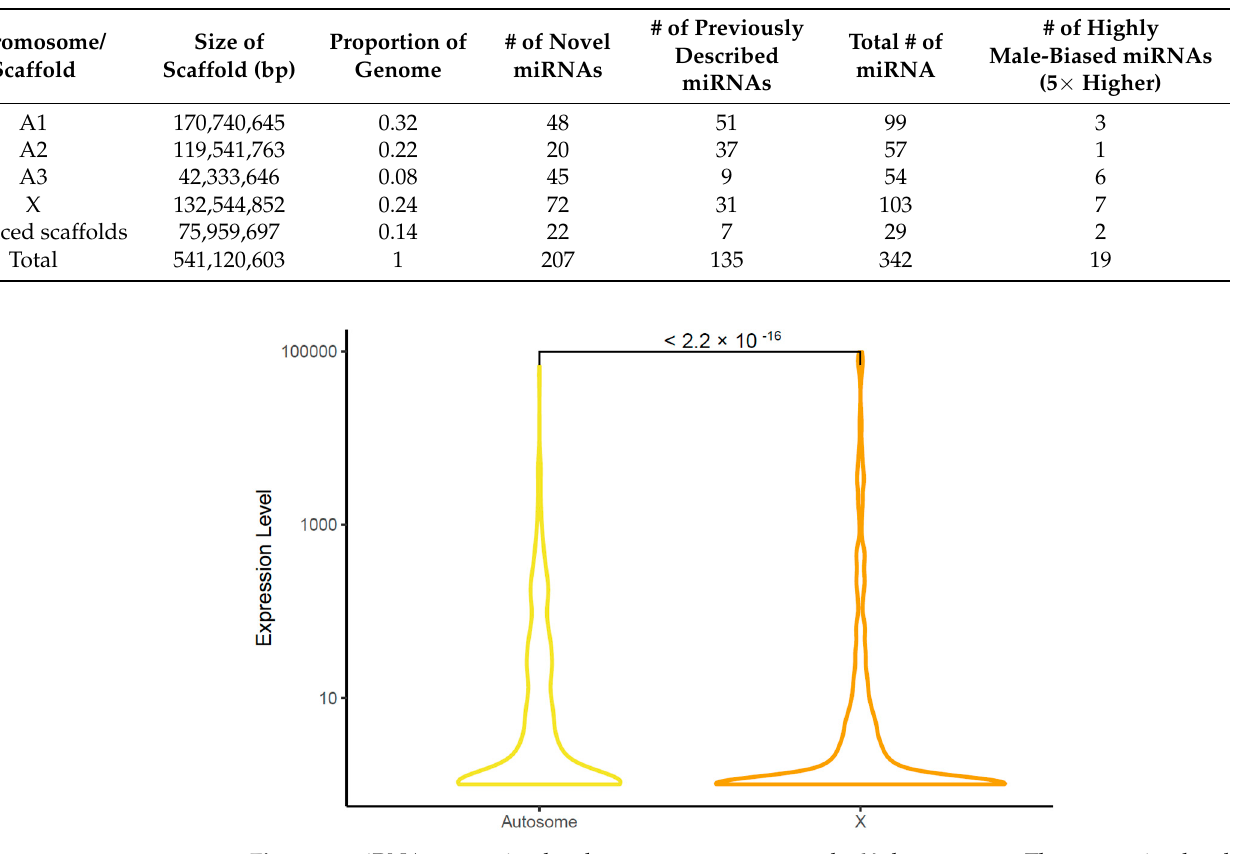
shown on the y -axis in terms of log10 (cpm + 1). Colors indicate chromosome type (autosome: yel-